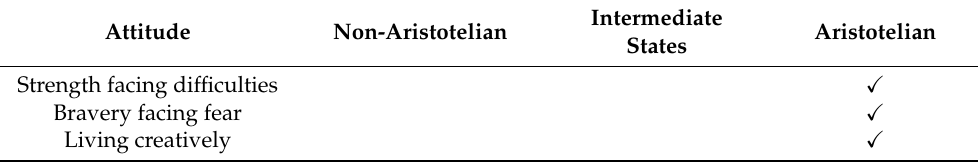
Intermediate Aristotelian Intermediate States Aristotelian States ✓ ✓ ✓